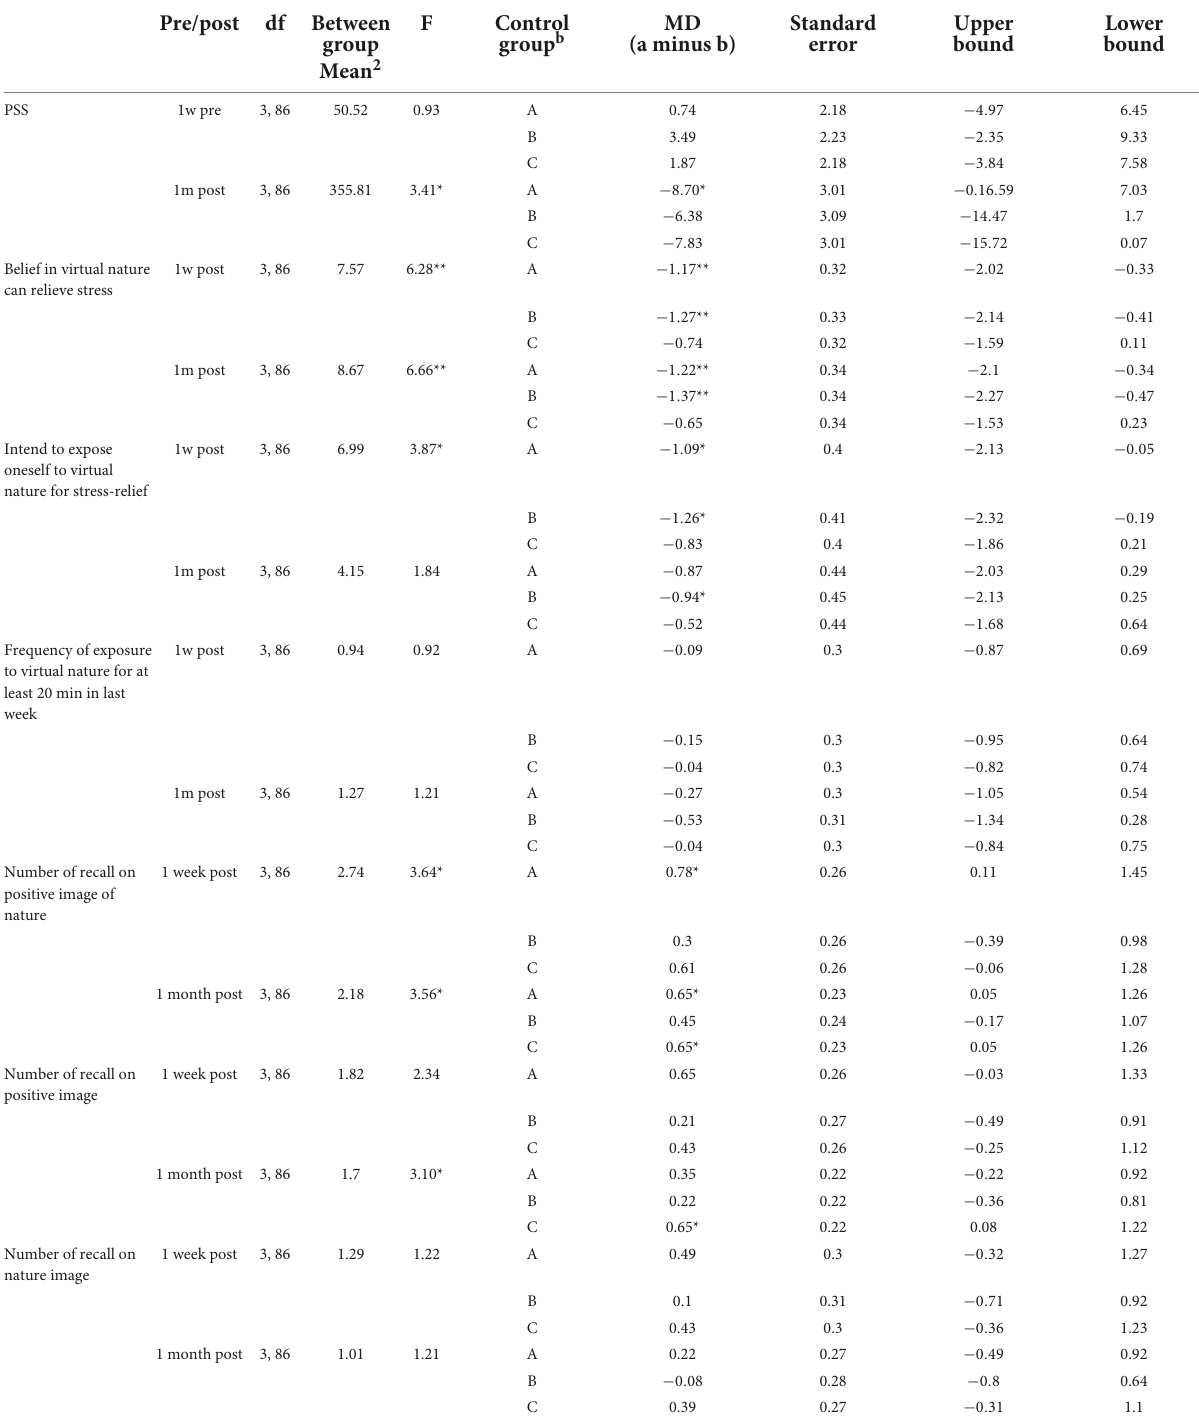
TABLE 5 One way ANOVA on PSS, virtual items and recall items, comparing experimental group with three control groups ( N = 90).